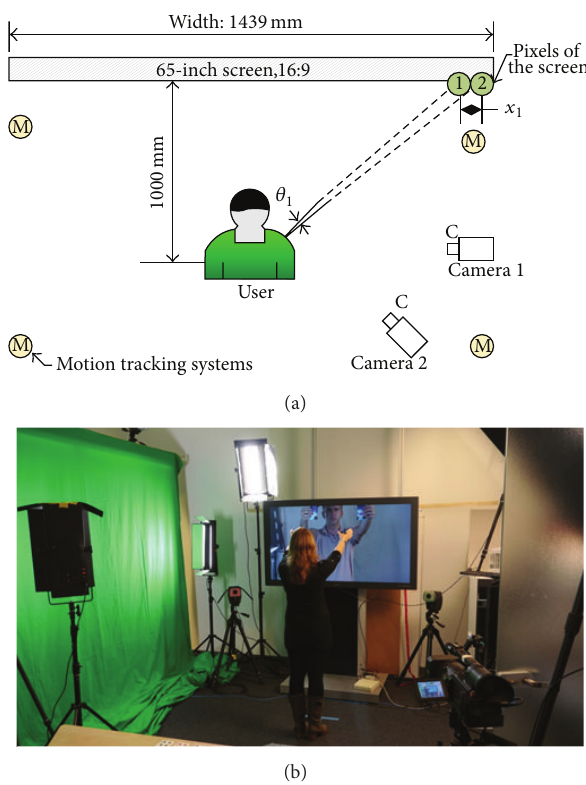
Figure 2: The setup of the experiment.